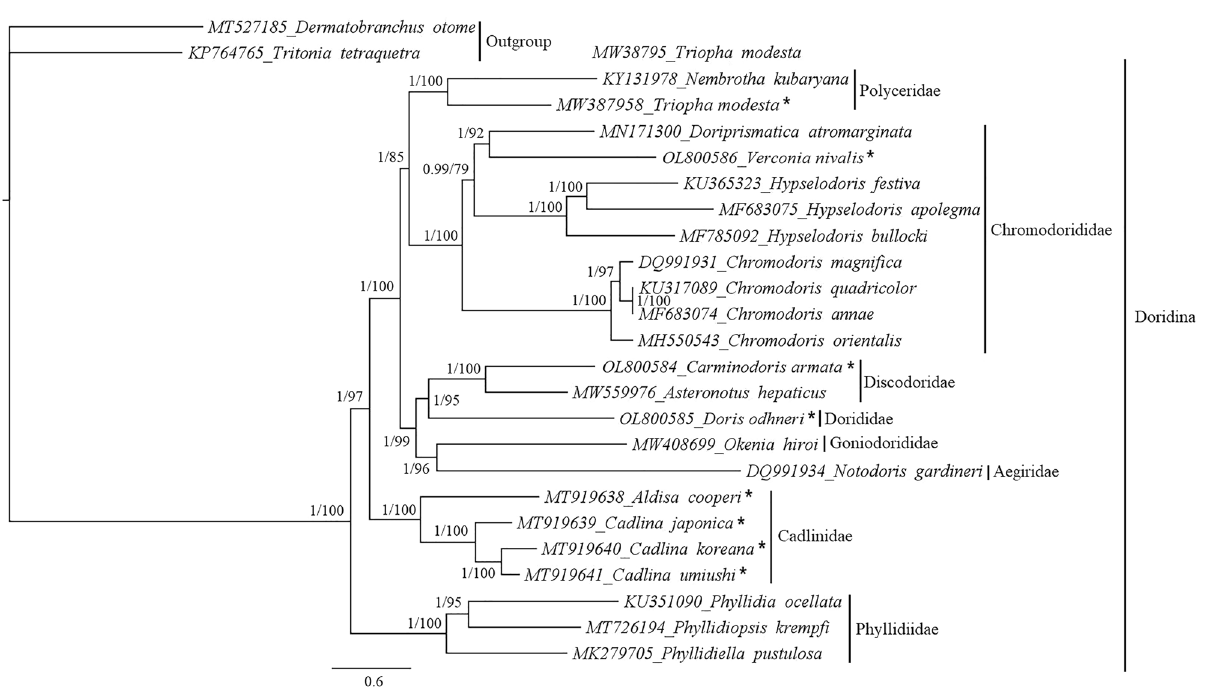
Figure 2. Phylogenetic tree showing the interfamily relationships of dorid nudibranchs based on the nucleotide sequences of 12 PCGs + 2 rRNAs + 22 tRNAs from mitogenomes ( nd4l excluded). Sequences generated in this study are marked with stars. GenBank accession numbers are indicated next to species names. Gblocks was used after sequence alignment. Posterior possibility values (left) and ultrafast bootstrap values (right) are shown at the nodes. Species of the suborder Cladobranchia were used as